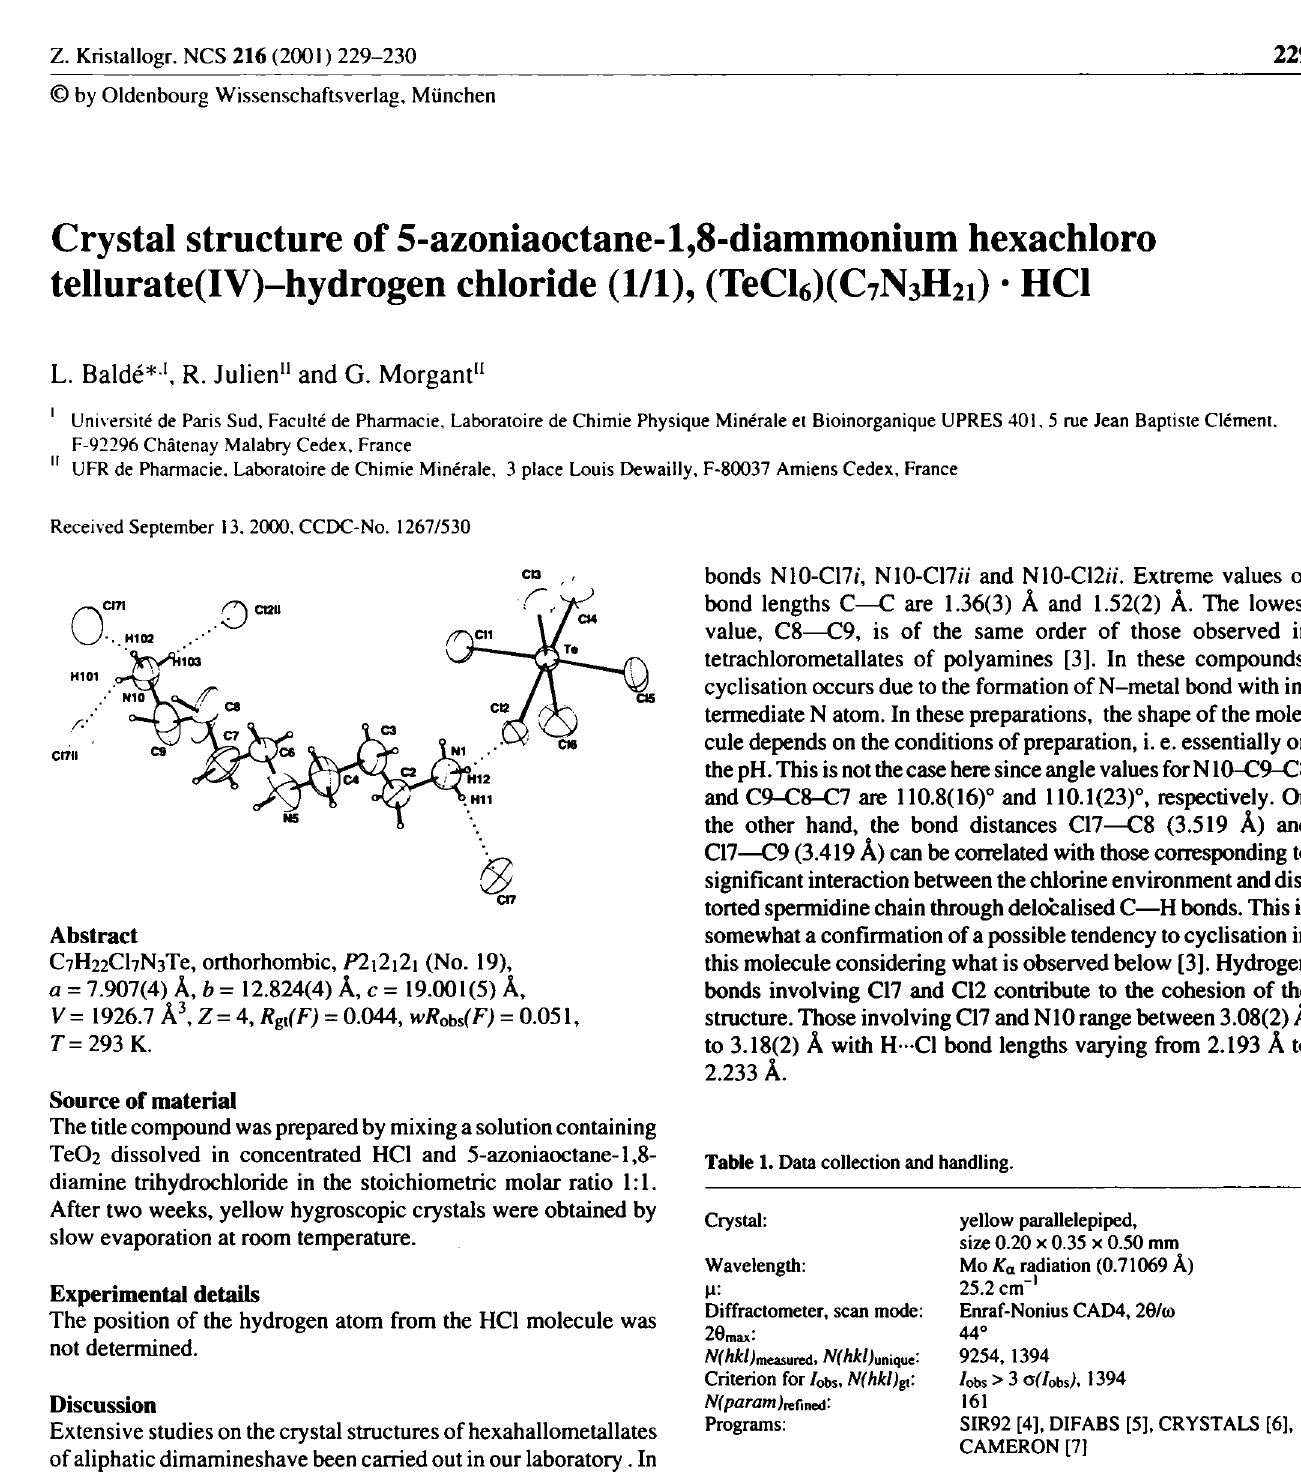
Table 2. Atomic coordinates and displacement parameters (in Ä 2